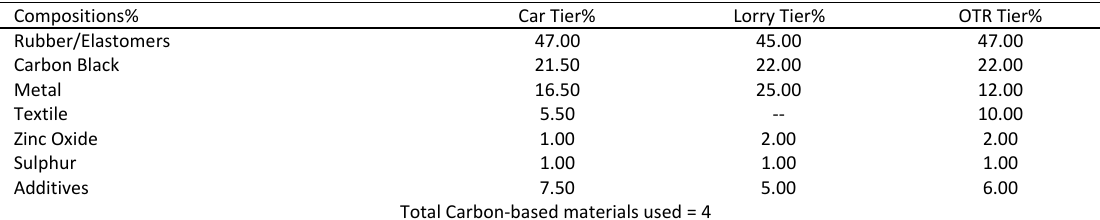
Table 1: Composition of Tier (WRAP, 2006) Table 1 : Composition of Tier (WRAP,